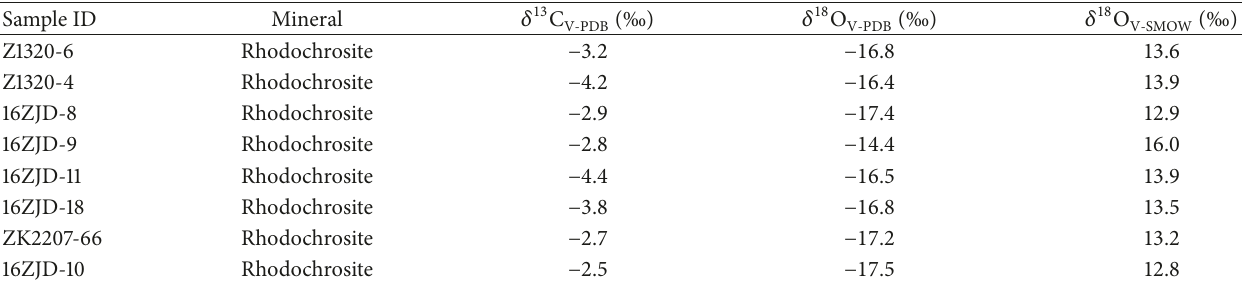
Figure 12: Plot of 208 Pb/ 204 Pb versus 206 Pb/ 204 Pb (a) and 207 Pb/ 204 Pb versus 206 Pb/ 204 Pb (b) for the sulfides (sphalerite and galena) and quartz porphyry (subvolcanic rocks) from the Zhijiadi deposit. The base map is from [34]. These ranges of subvolcanic rocks (quartz porphyry and granite porphyry) are quoted from the data of [35]. Table 2: Carbon and oxygen isotope data of rhodochrosite from the Zhijiadi Ag-Pb-Zn